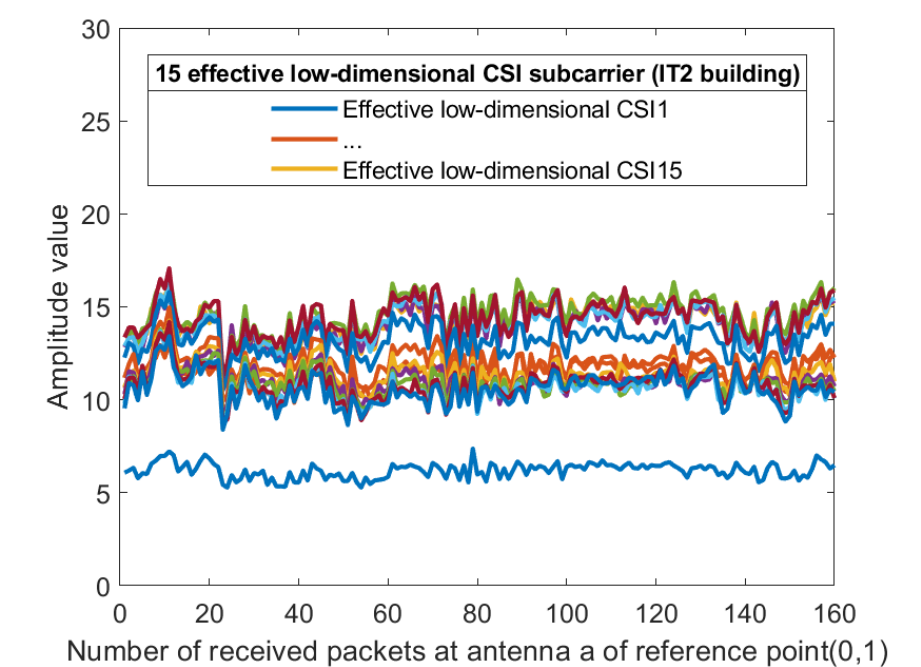
Figure 11. The amplitude of the effective CSI sub-carriers on antenna a at reference point (0,1) of AP1 in the lobby of IT2